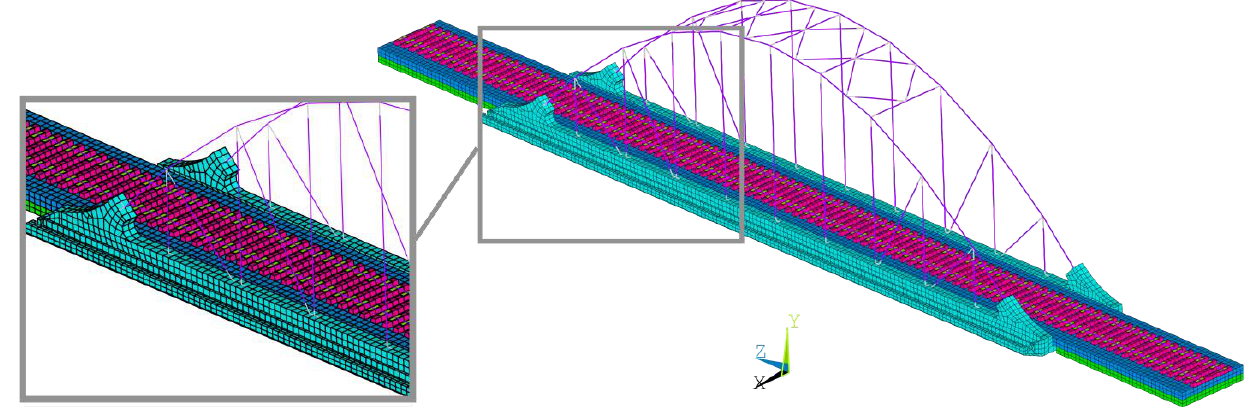
Figure 2. The 3D model of the São Lourenço bridge including the track. while, for the arches, hangers, diagonals, and bracings beam elements were used. The pot one, i.e., with a length of 2.60 m and a trapezoidal cross-section with a lower width